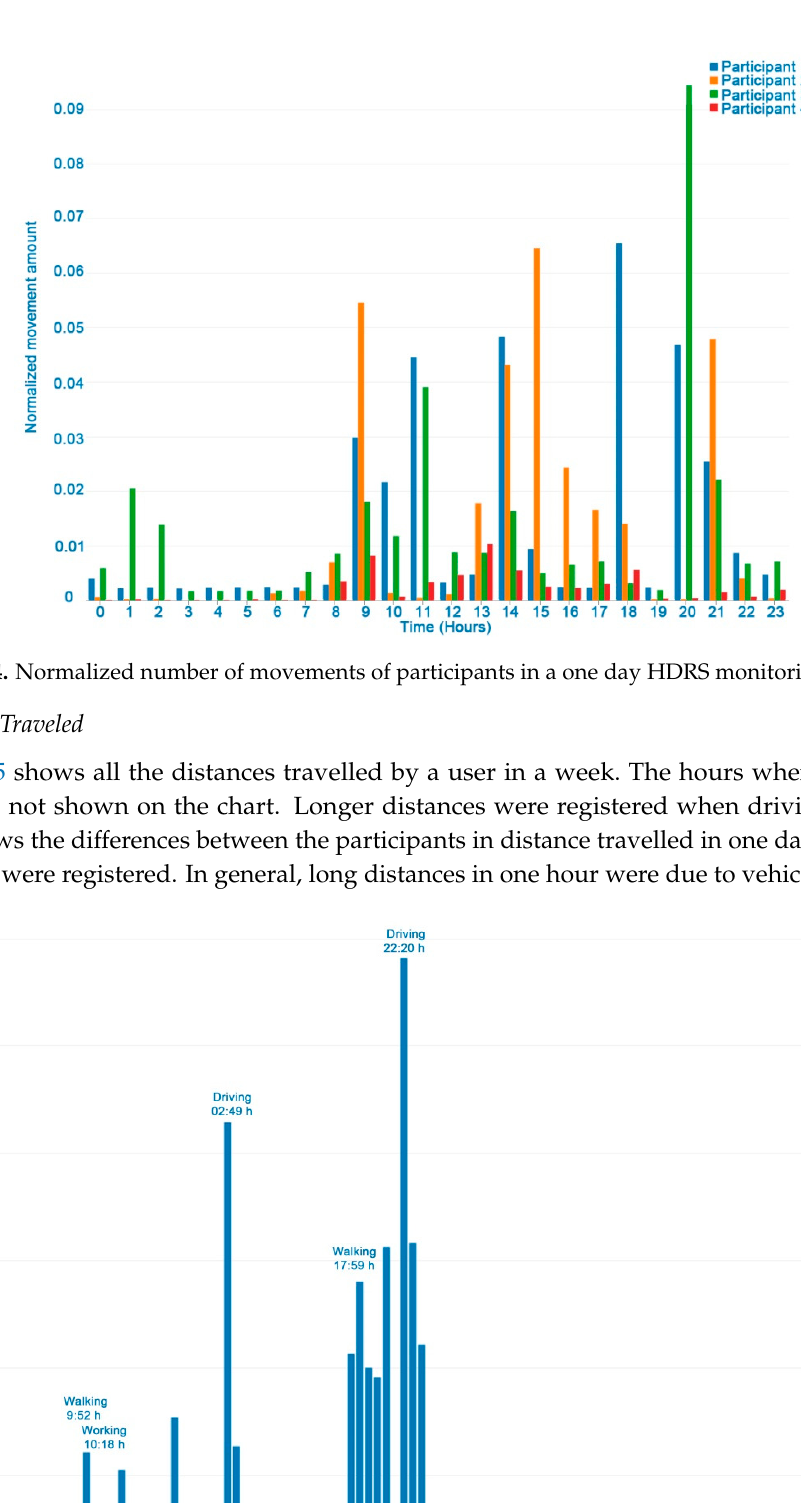
Figure 6. Distance travelled by participants (m) in a day of HDRS monitoring. 3.3. Mobile Data Traffic and Conversation Figure 7 shows the data traffic (Mb) and conversations of a user in a week. Conversation is frequent when eating, working, walking, and watching TV, showing the relationship between conversation and social activities, although filters are needed to differentiate between conversation and sounds from the TV or the environment. Figure 8 shows the differences between the participants’ data traffic in a day. In general, more data traffic is registered in the early afternoon (2–